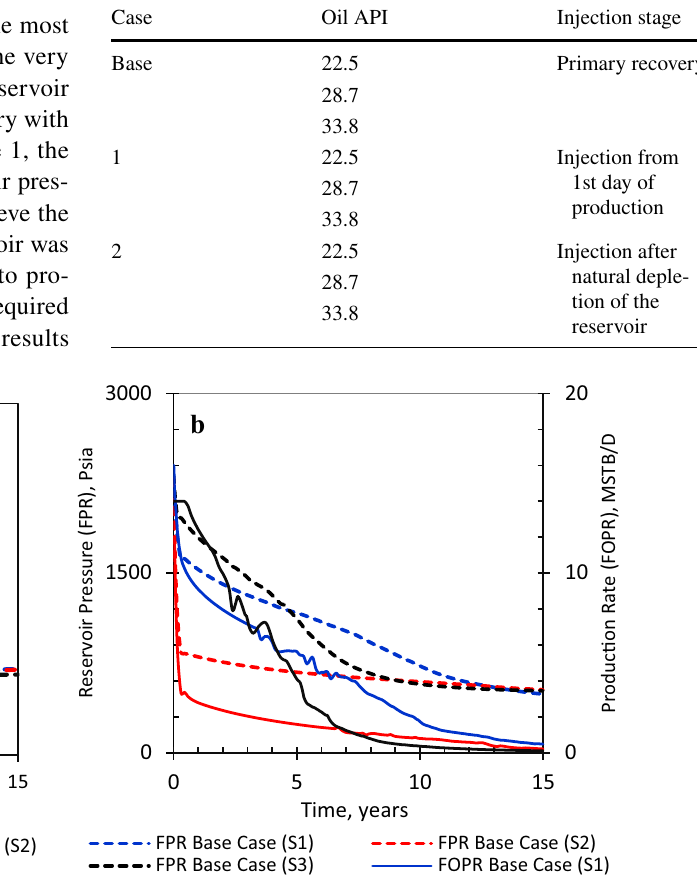
Fig. 8 Hypothetical model (top layer) of the base case reservoir showing the variation of saturation after 15 years of production Table 3 Different development schemes